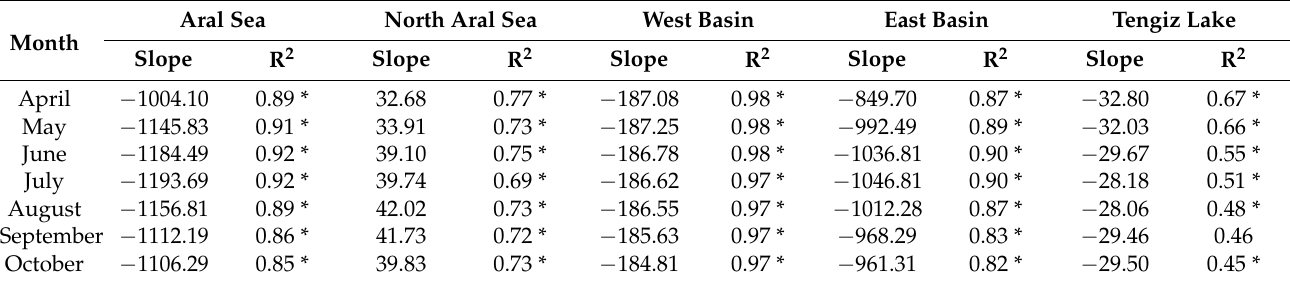
Table 6. The monthly dynamics statistics of the Aral Sea and Tengiz Lake.